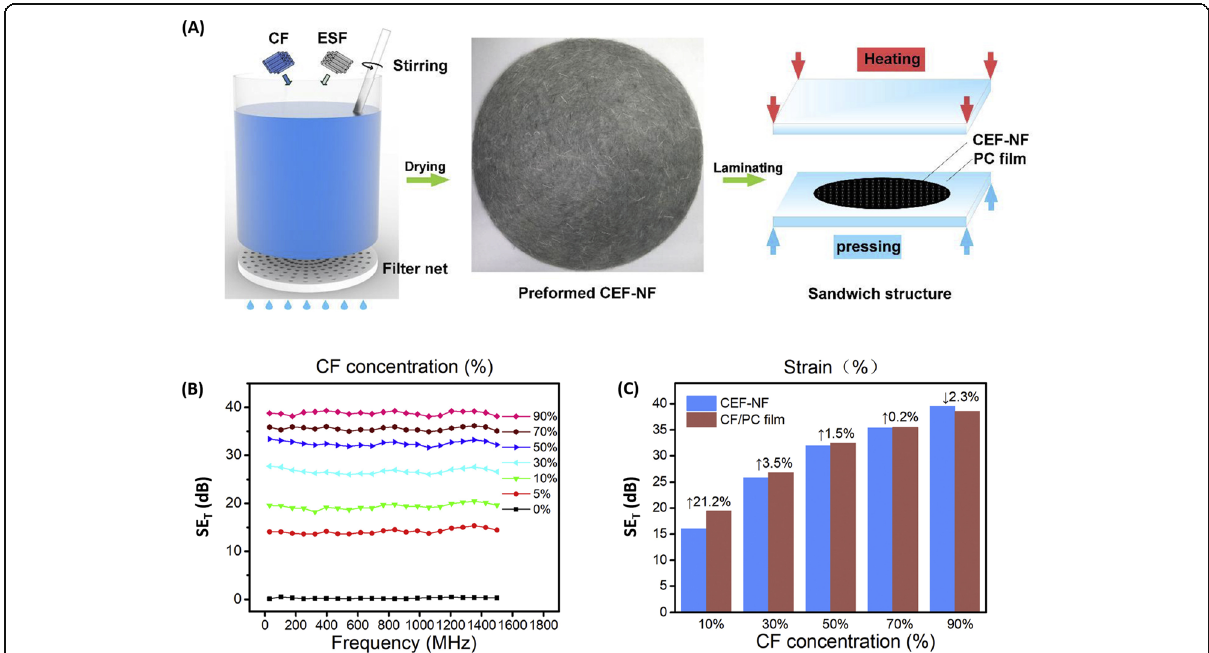
Fig. 18 (A) Schematic of the CF/PC film preparation (ESF refers to polypropylene/polyethylene (PP/PE) core/sheath bi-component fibers); ( B ) SE T values of composites- x % in the 30 – 1500MHz frequency range; ( C ) SE T comparisons between CEF-NF- x % and composites- x %. Adapted with